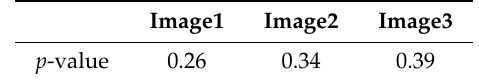
Table 5. P -value of three test images.